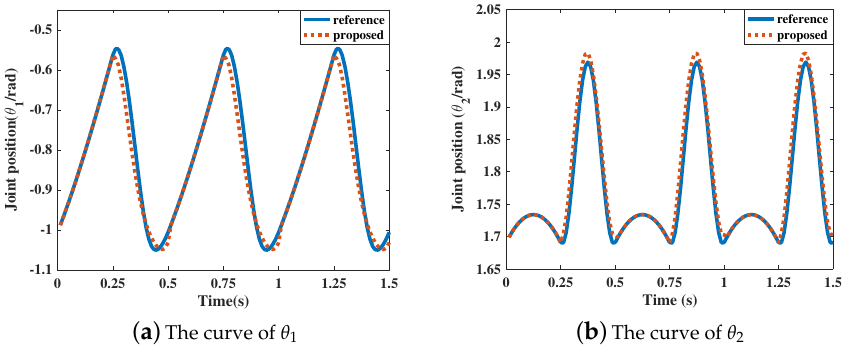
Figure 9. Joint positions of the RF leg in MATLAB.